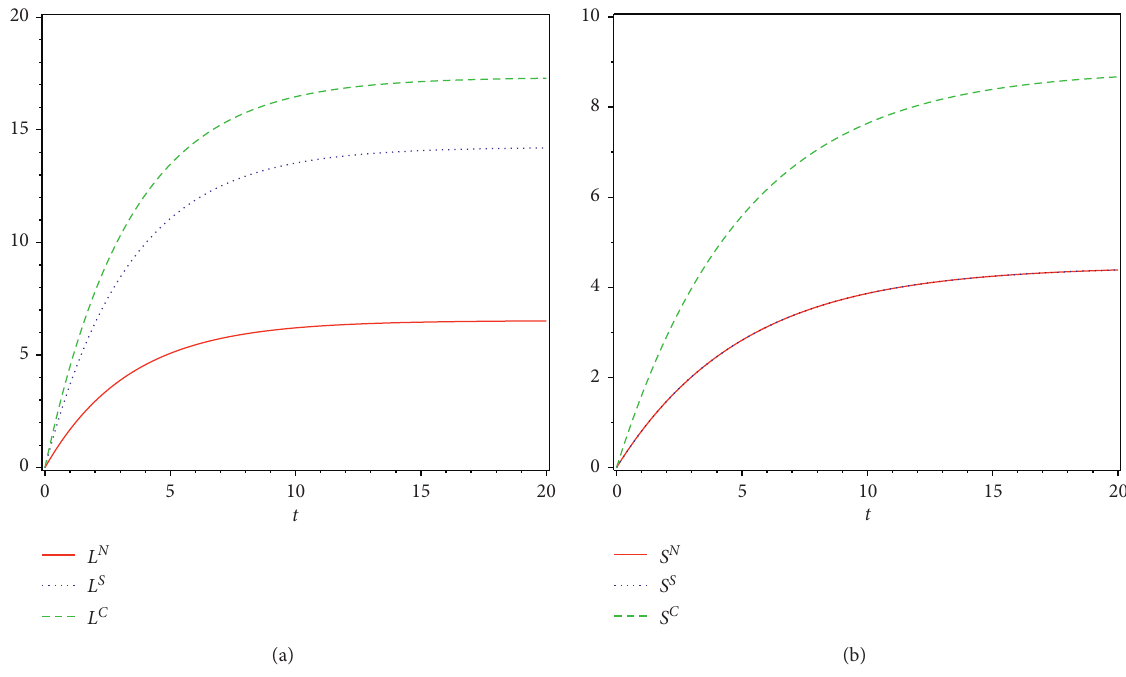
Figure 1: (a) Joint innovation level and (b) joint social responsibility level under three game